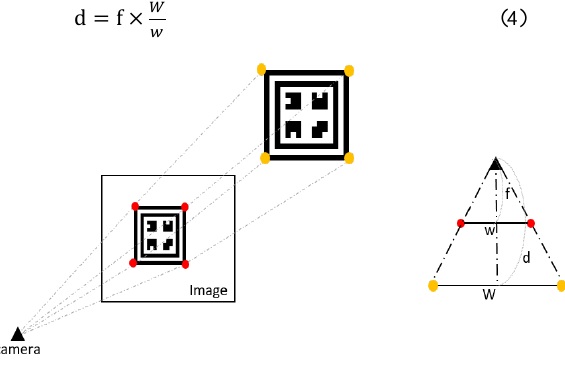
Figure4. The concept of distance